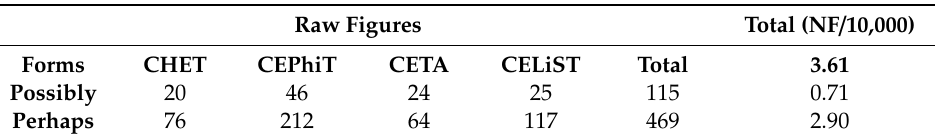
Table 3. Frequency of possibly and perhaps in the subcorpora.